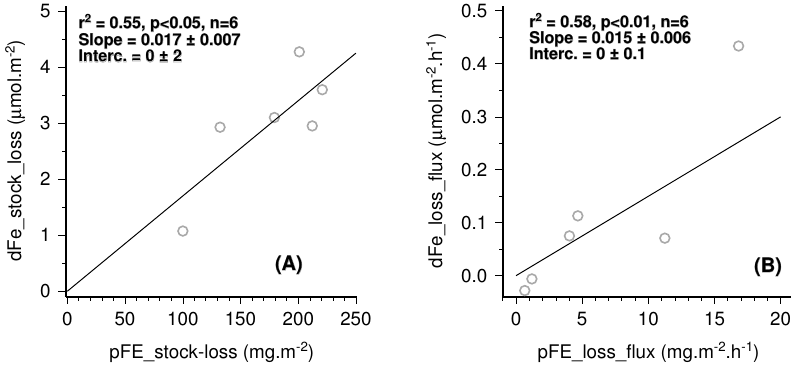
Fig. 6. Correlation between dFe and pFe stock loss (a) and fluxes of dFe and pFe loss (b) . The definition and description of the calculation of this parameters can be found in the text (Sect.